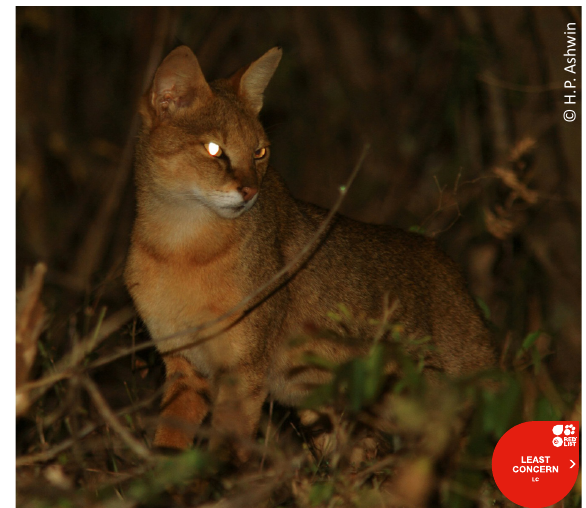
Image 5. Jungle Cat Felis chaus